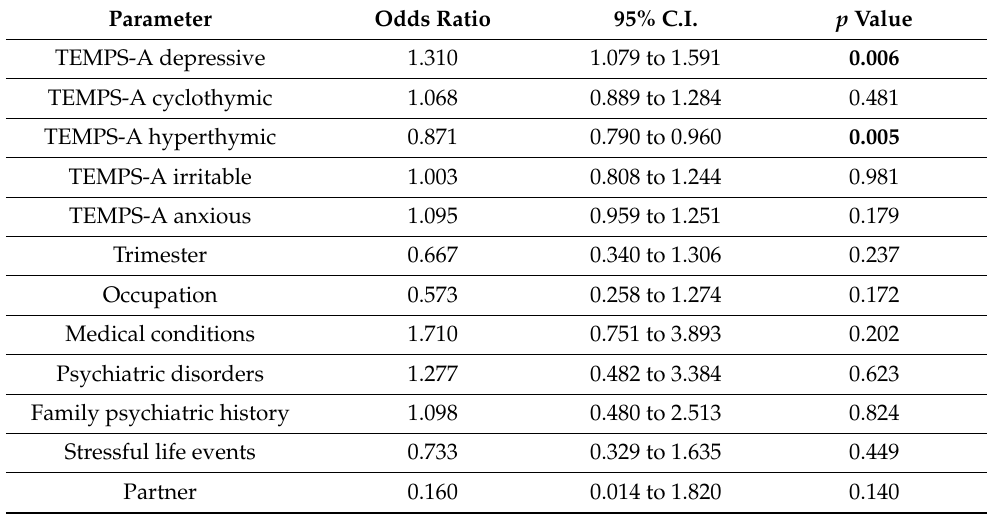
Table 2. Logistic regression.